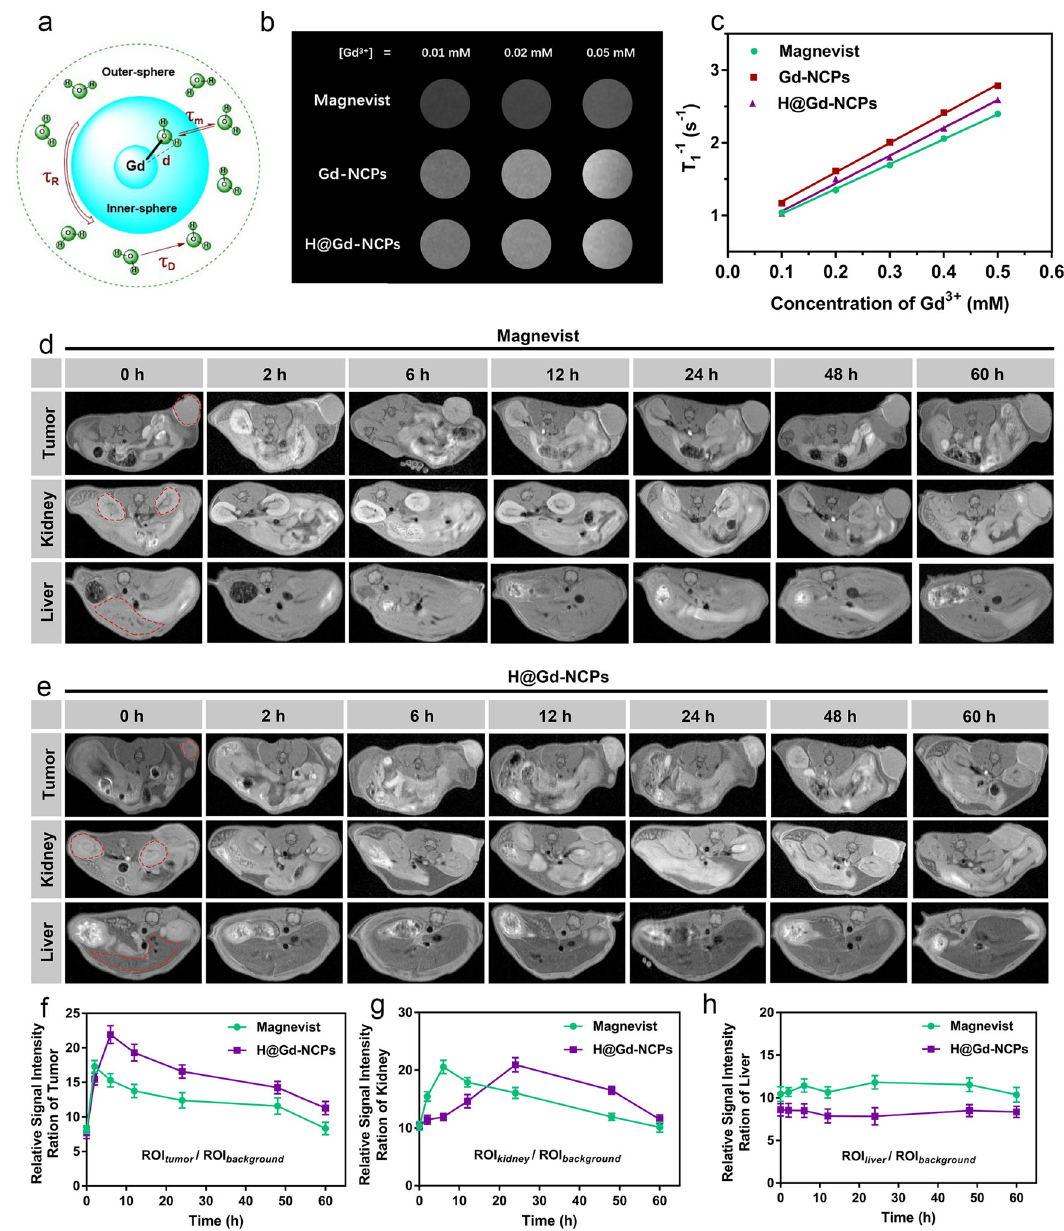
Fig. 4 Magnetic resonance imaging (MRI) in vitro and in vivo. a Schematic diagram of MRI. b T 1 -weighted MR images of Magnevist, Gd-NCPs, and H@Gd-NCPs at pH 7.4 ( n = 3 biologically independent samples), this experiment was repeated twice independently with similar results. c Determination of longitudinal relaxivities ( r 1 ) values for Magnevist, Gd-NCPs and H@Gd-NCPs ( n = 3 biologically independent samples), this experiment was repeated twice independently with similar results. d Dynamic MR imaging after intravenous injection of Magnevist ([Gd 3 + ] = 30mg kg − 1 ), and the dashed red circles indicated tumor, kidney, or liver ( n = 3 biologically independent animals). e Dynamic MRI after intravenous injection of H@Gd-NCPs ([Gd 3 + ] = 30 mgkg − 1 ) in vivo, and the dashed red circles indicated tumor, kidney and liver, respectively ( n = 3 biologically independent animals). f – h Relative background signal intensity ration of tumor ( f ), kidney ( g ) and liver ( h ) regions based on Magnevist MR images ( d ) and H@Gd-NCPs MR images ( e ) at different time points ( n = 3 biologically independent samples). All data were presented as mean± SD. Source data are provided as a Source data fi